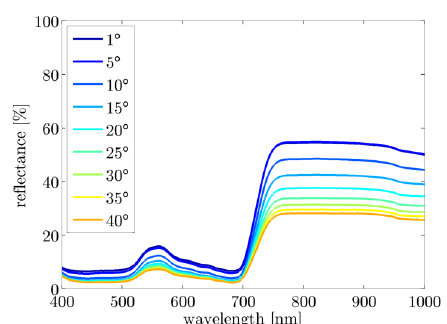
Figure 1: Average hyperspectral plant signatures for speci fi c in- clination